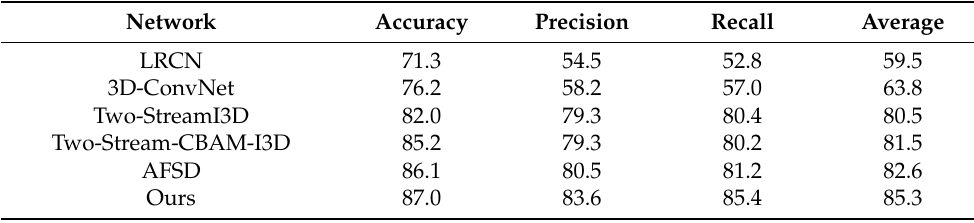
Table 3. Performance evaluation table for action recognition